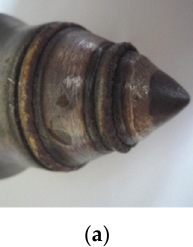
Figure 4. Experimental assembly used for laser metal deposition using a robotic cell: (1) welding robot; (2) processing head-laser deposition module; (3) tooth rotating and positioning device; (4) rotating and positioning table.